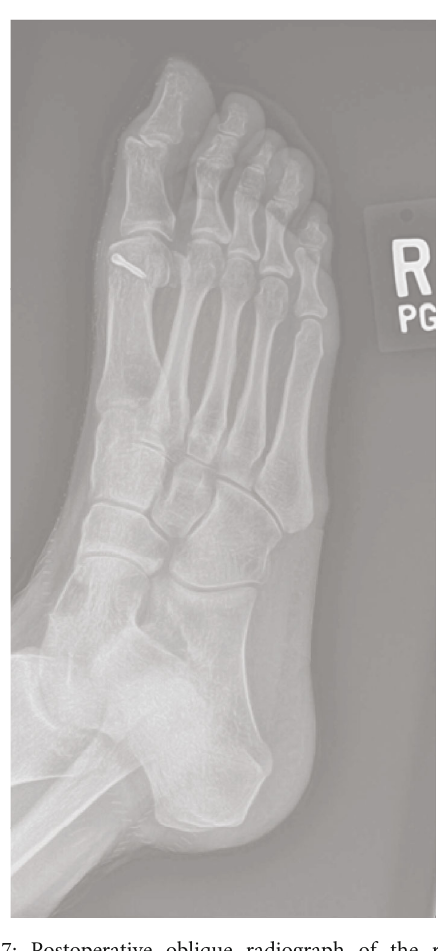
Figure 7: Postoperative oblique radiograph of the right foot demonstrating hallux rigidus correction with OCA implantation on the metatarsal head.